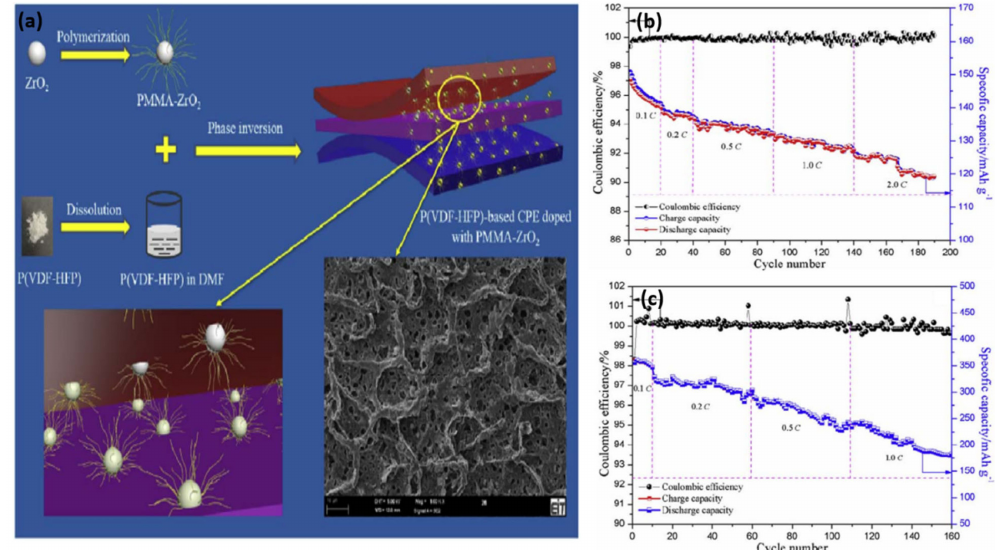
Figure 16. ( a ) Schematic of the GPE-sPZ hybrid particles. ( b , c ) Cyclic performance and Coulombic efficiency of the Li/CPE- sPZ/LiCoO 2 and Li/CPE-sPZ/graphite coin cells at different C-rates at room temperature. Reprinted with permission from Xiao et al [120]. Copyright 2018 Elsevier